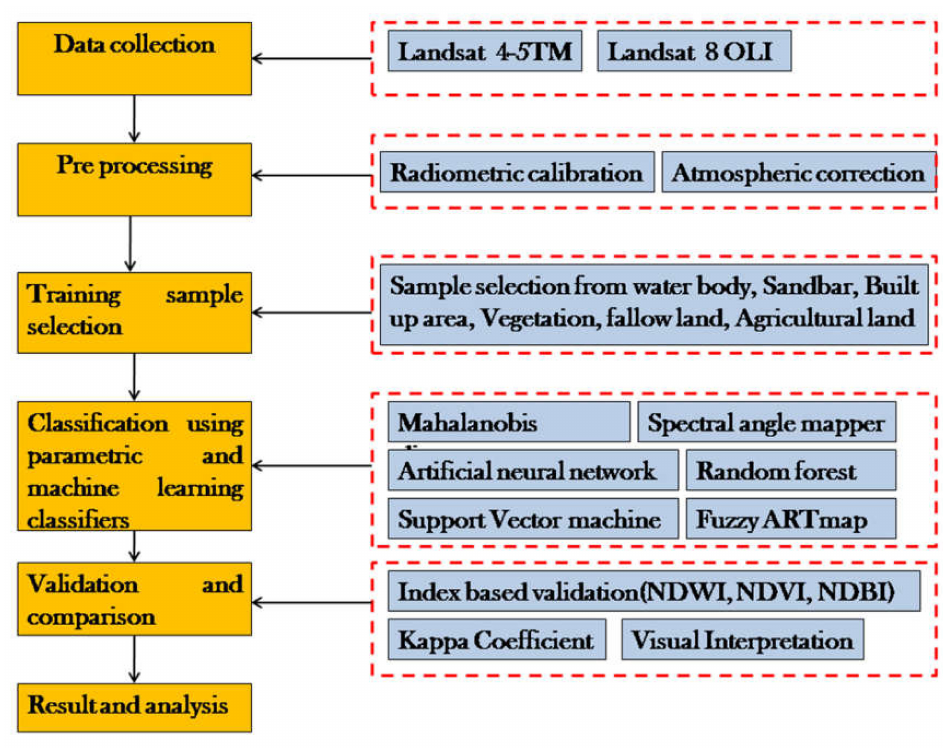
Figure 2. Flowchart of the methodology.